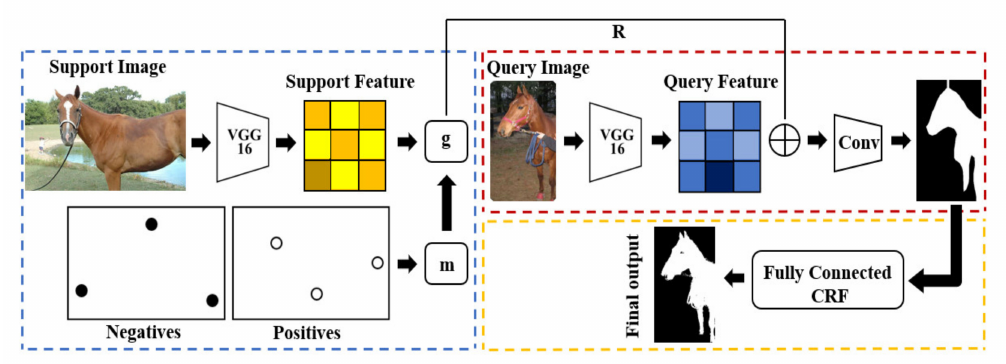
Figure 1. Proposed model overview. See Section 4 for